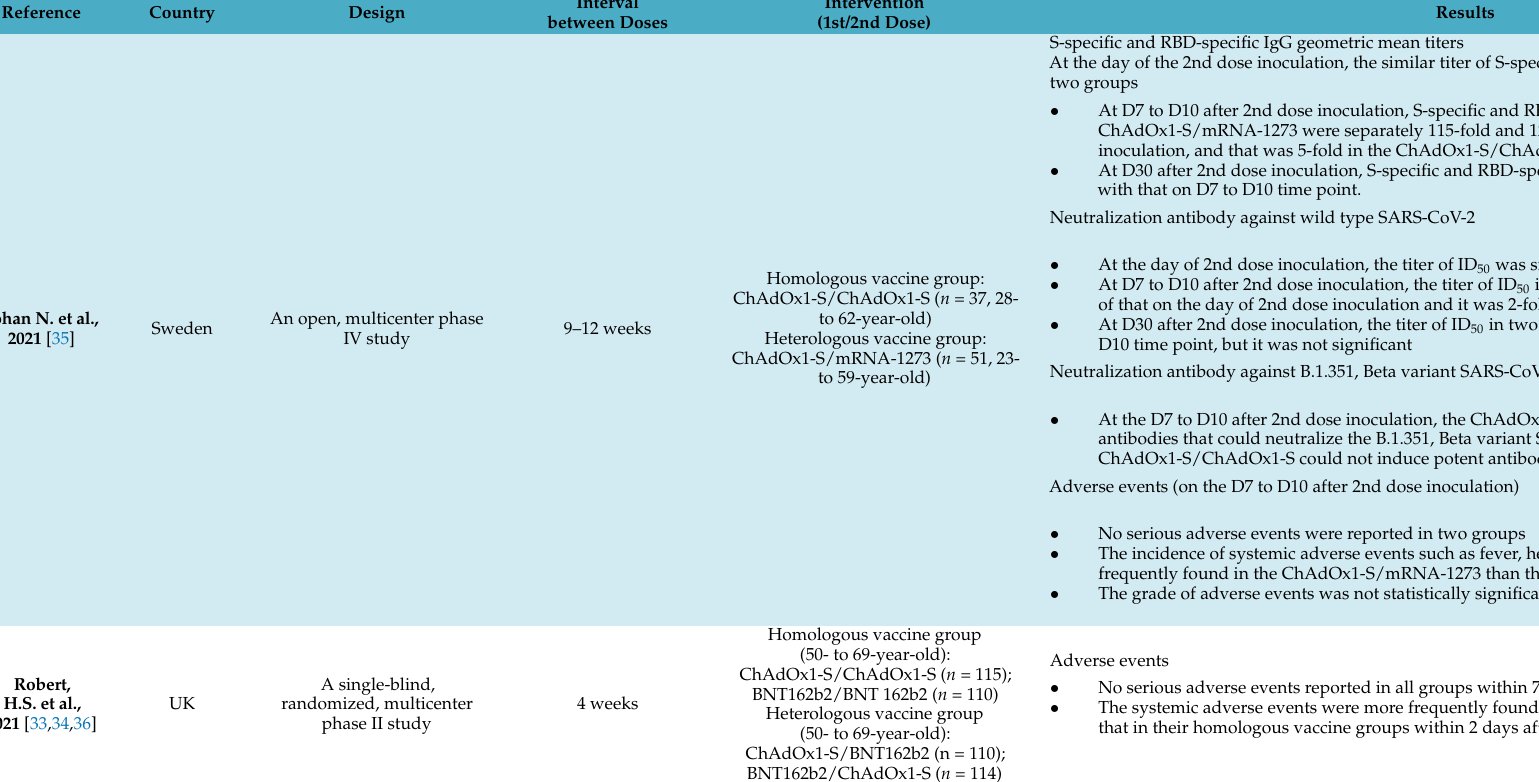
Table 2. Studies of heterologous ChAdOx1-S with mRNA